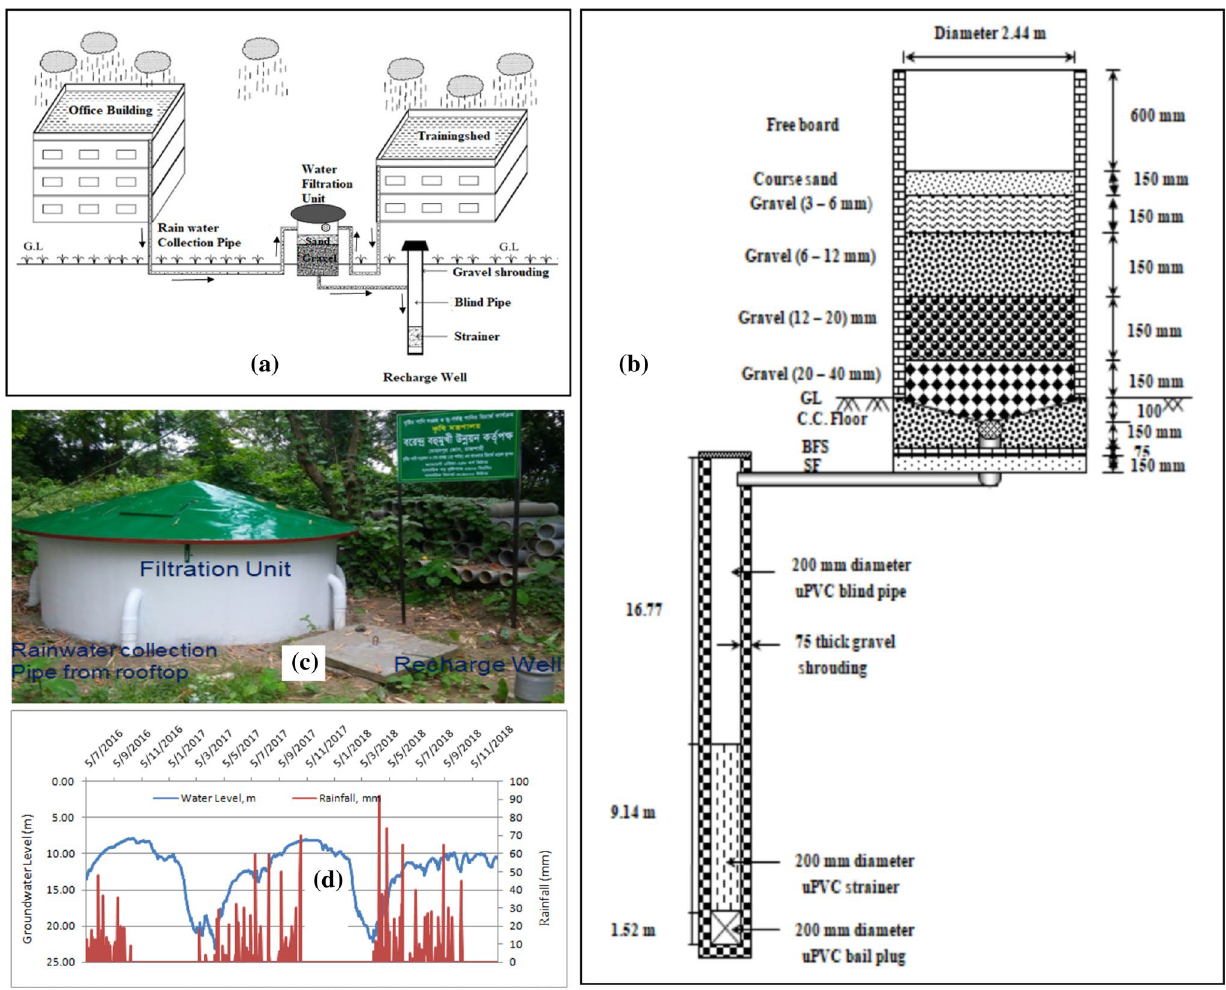
Fig. 9 BMDA Mohanpur office campus MAR model- a Schematic view of complete MAR model, b Longitudinal sectional view of FU and RW, c Photograph of FU with RW and d GWL hydrograph showing recharge performance with the infiltration of rain